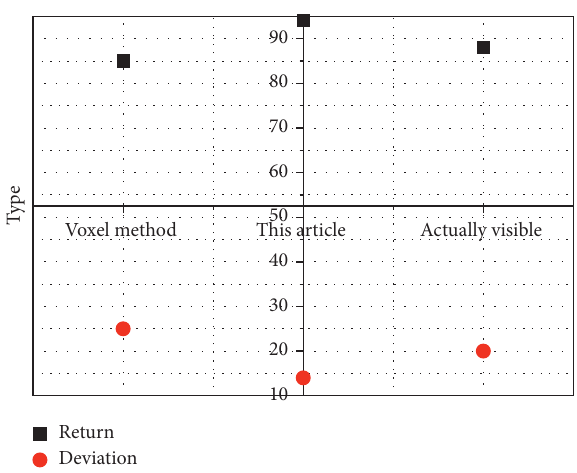
Figure 5: Comparison of model